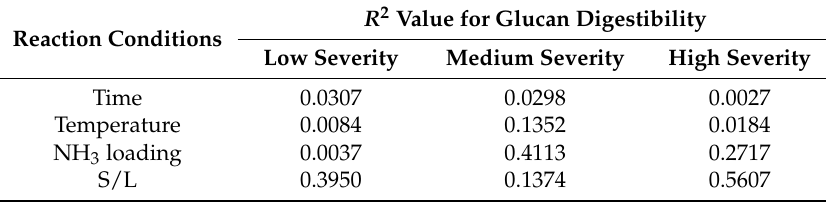
Table 4. Effects of residual ammonia content on glucan digestibility under various reaction conditions.